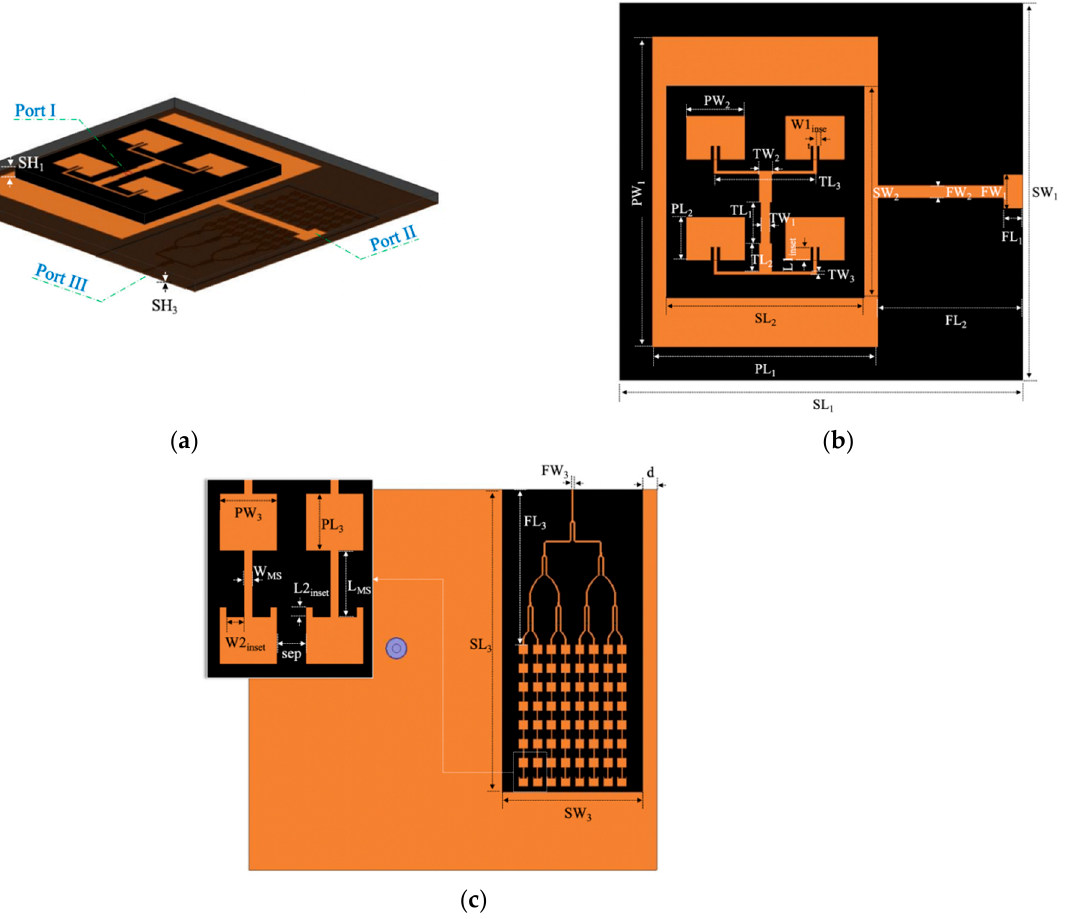
Figure 2. Dimensions and geometry of proposed low-profile triple-frequency antenna from ( a ) dimetric view, ( b ) top view, and ( c ) bottom view.